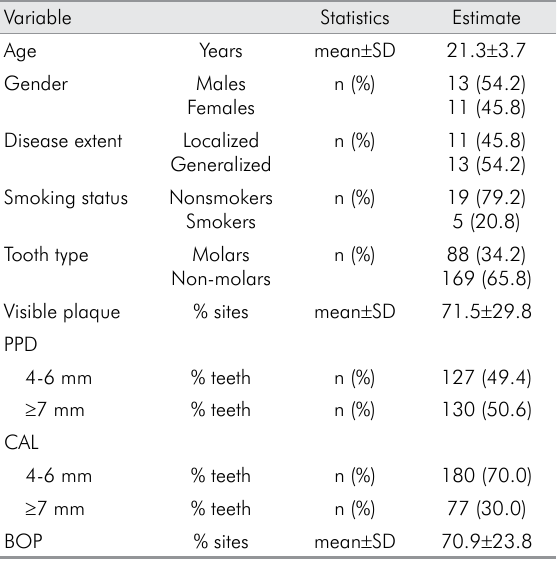
Table 1. Study sample characteristics at baseline